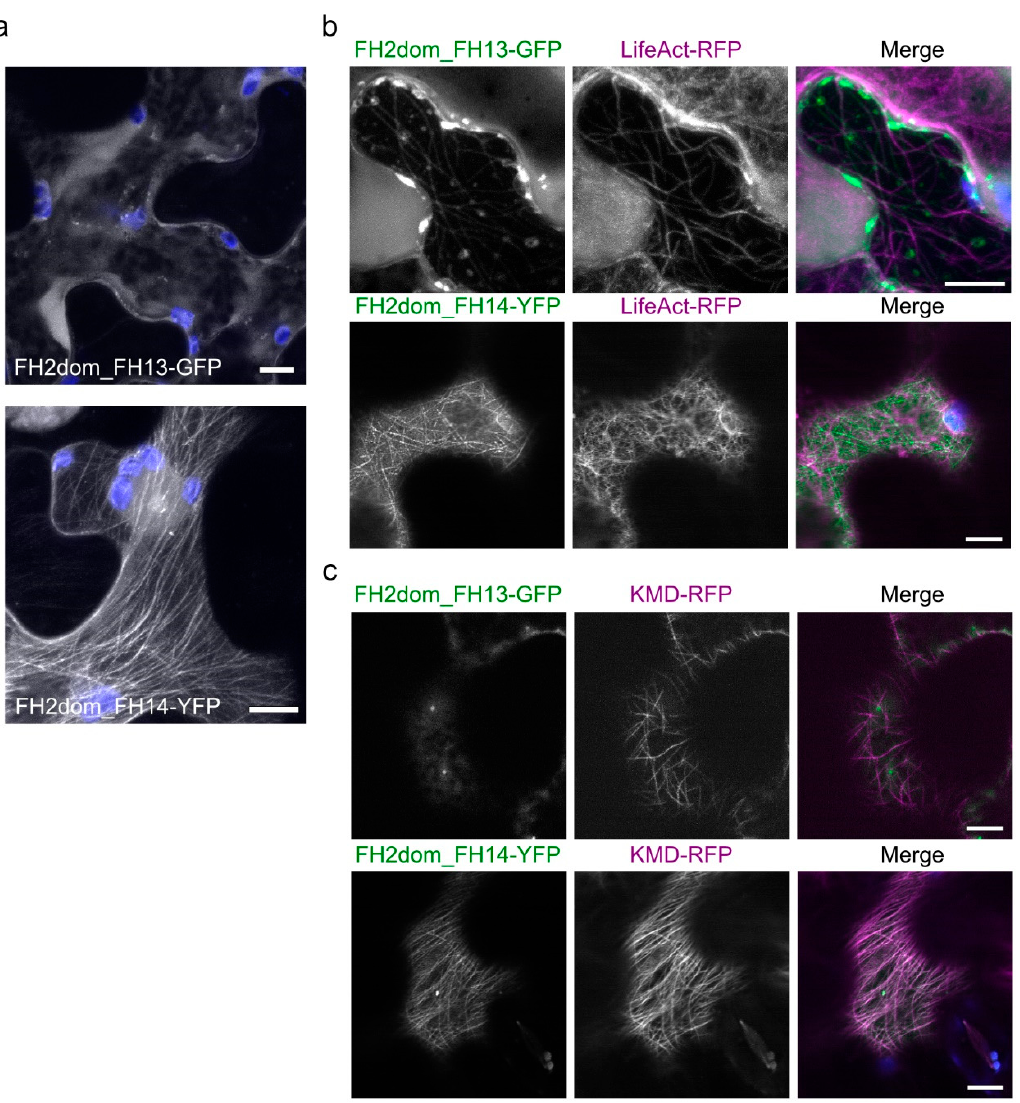
Figure 7. Localization of isolated FH2 domains of AtFH13 and AtFH14 in tobacco epidermal cells. ( a ) Maximal intensity projections of Z-stacks of optical sections from cells expressing FH2dom_AtFH13-GFP and FH2dom_AtFH14-YFP constructs, respectively. Green (GFP) or yellow (YFP) fluorescence shown in grayscale, chlorophyll autofluorescence in blue. ( b ) Single optical sections of cells co-expressing FH2dom_AtFH13-GFP or FH2dom_AtFH14-YFP with LifeAct-RFP. ( c ) Single optical sections of cells co-expressing FH2dom_AtFH13-GFP and FH2dom_AtFH14-YFP with KMD-RFP. In ( b ) and ( c ), images from single channels are shown in grayscale, merged images display an overlay of three channels represented by green (GFP or YFP), magenta (RFP), and blue (chloroplast autofluorescence. Scale bars are 10 µm. Construct abbreviations are defined in the text and in Figure 1.